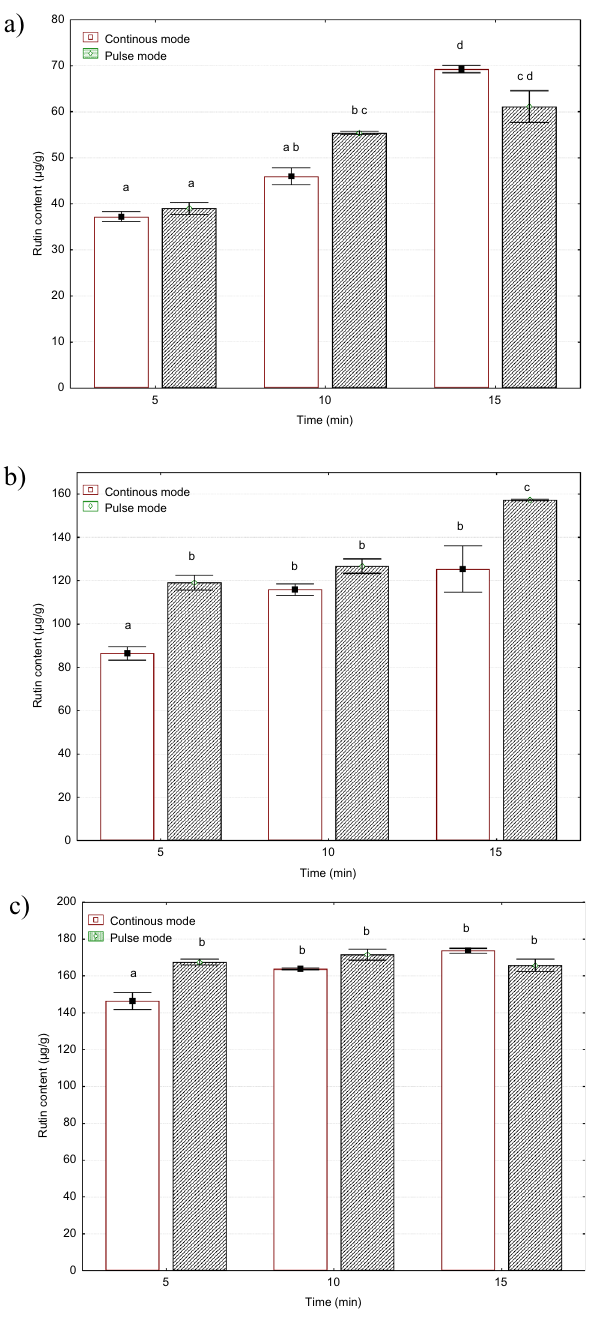
Figure 3. Effect of ultrasonic treatment parameters on the content of rutin (µg/g d.m.) in Sorbus intermedia berries extracts: ( a ) amplitude 12 µm, ( b ) amplitude 24 µm, ( c ) amplitude 36